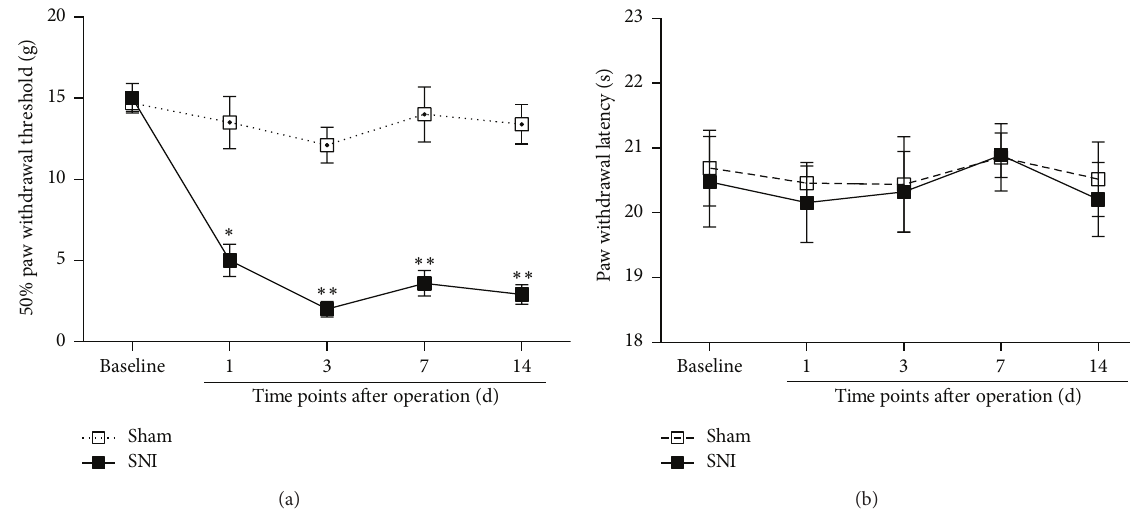
Figure 1: SNI produced significant mechanical allodynia but no thermal hyperalgesia in rats. (a) The 50% paw withdrawal threshold assessed by von Frey filaments was significantly lower after the SNI surgery ( 𝑛 = 8 ) compared to the sham ( 𝑛 = 8 ) group. Mechanical allodynia was obvious at day 1 and persisted for at least 2 weeks. (b) Paw withdrawal latency measured by radiant heat was not changed after the SNI surgery ( 𝑛 = 8 ) compared to the sham ( 𝑛 = 8 ) group ( ∗ 𝑃 < 0.05 and ∗∗ 𝑃 < 0.01 compared to the sham control at the same time